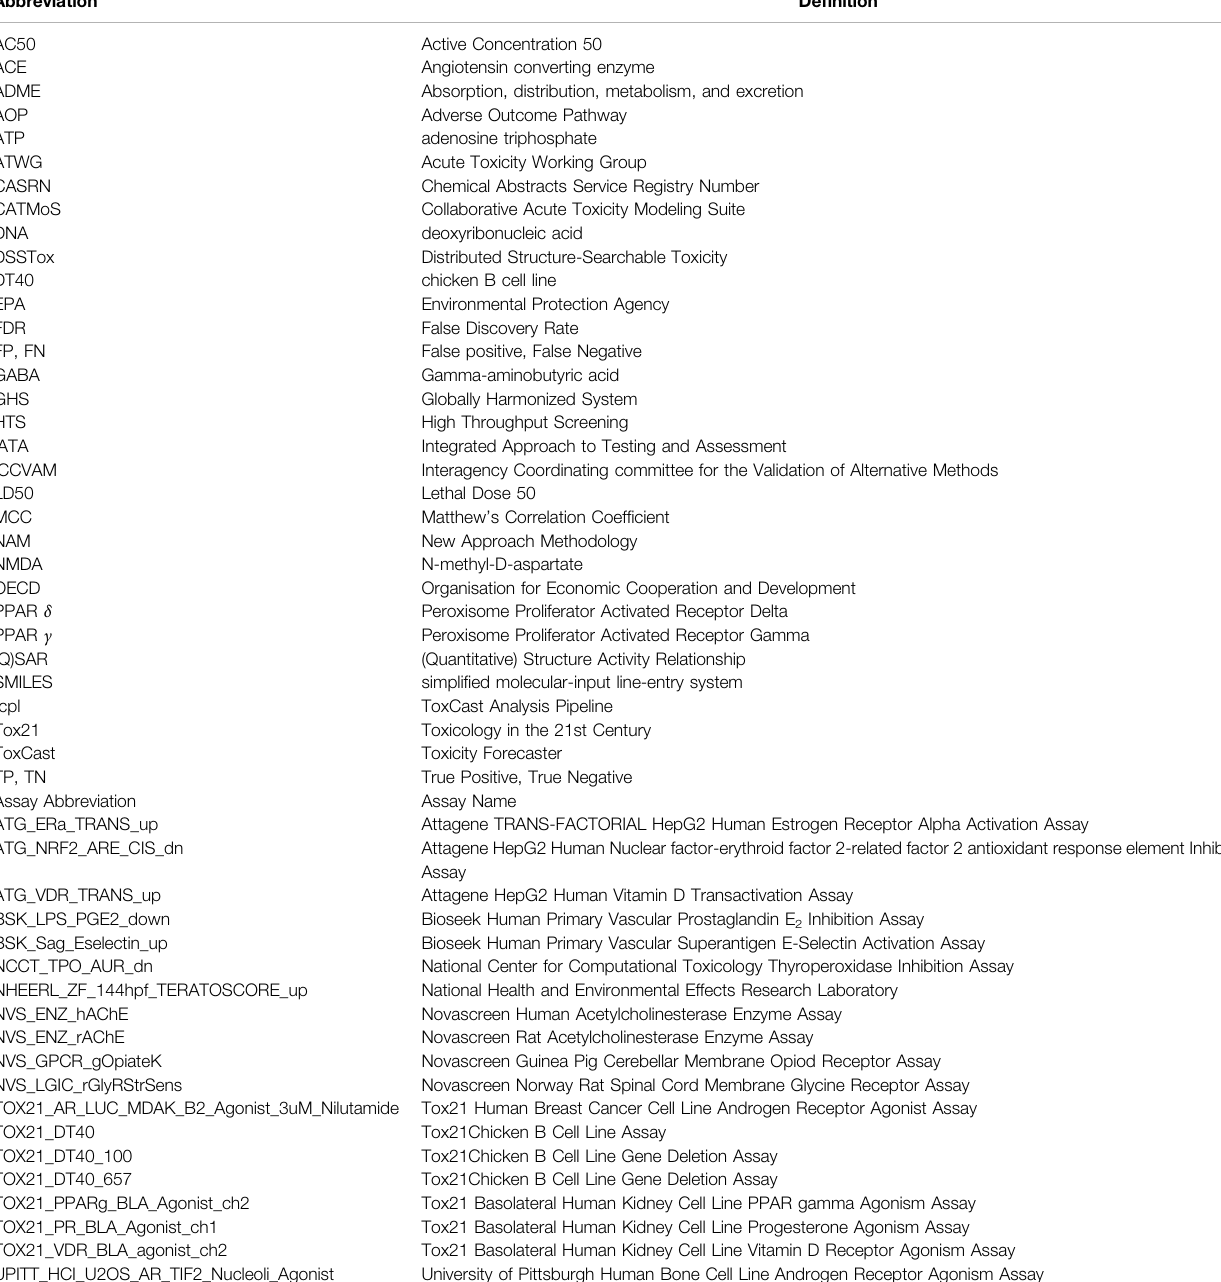
TABLE 1 | Summary of abbreviations and assay names used in the text.